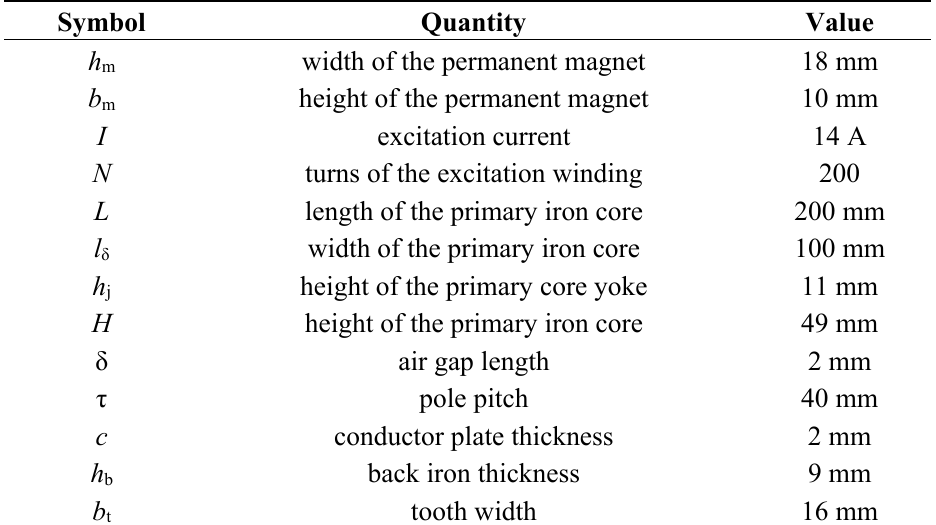
Table 1. Initial parameters of the hybrid excitation linear eddy current